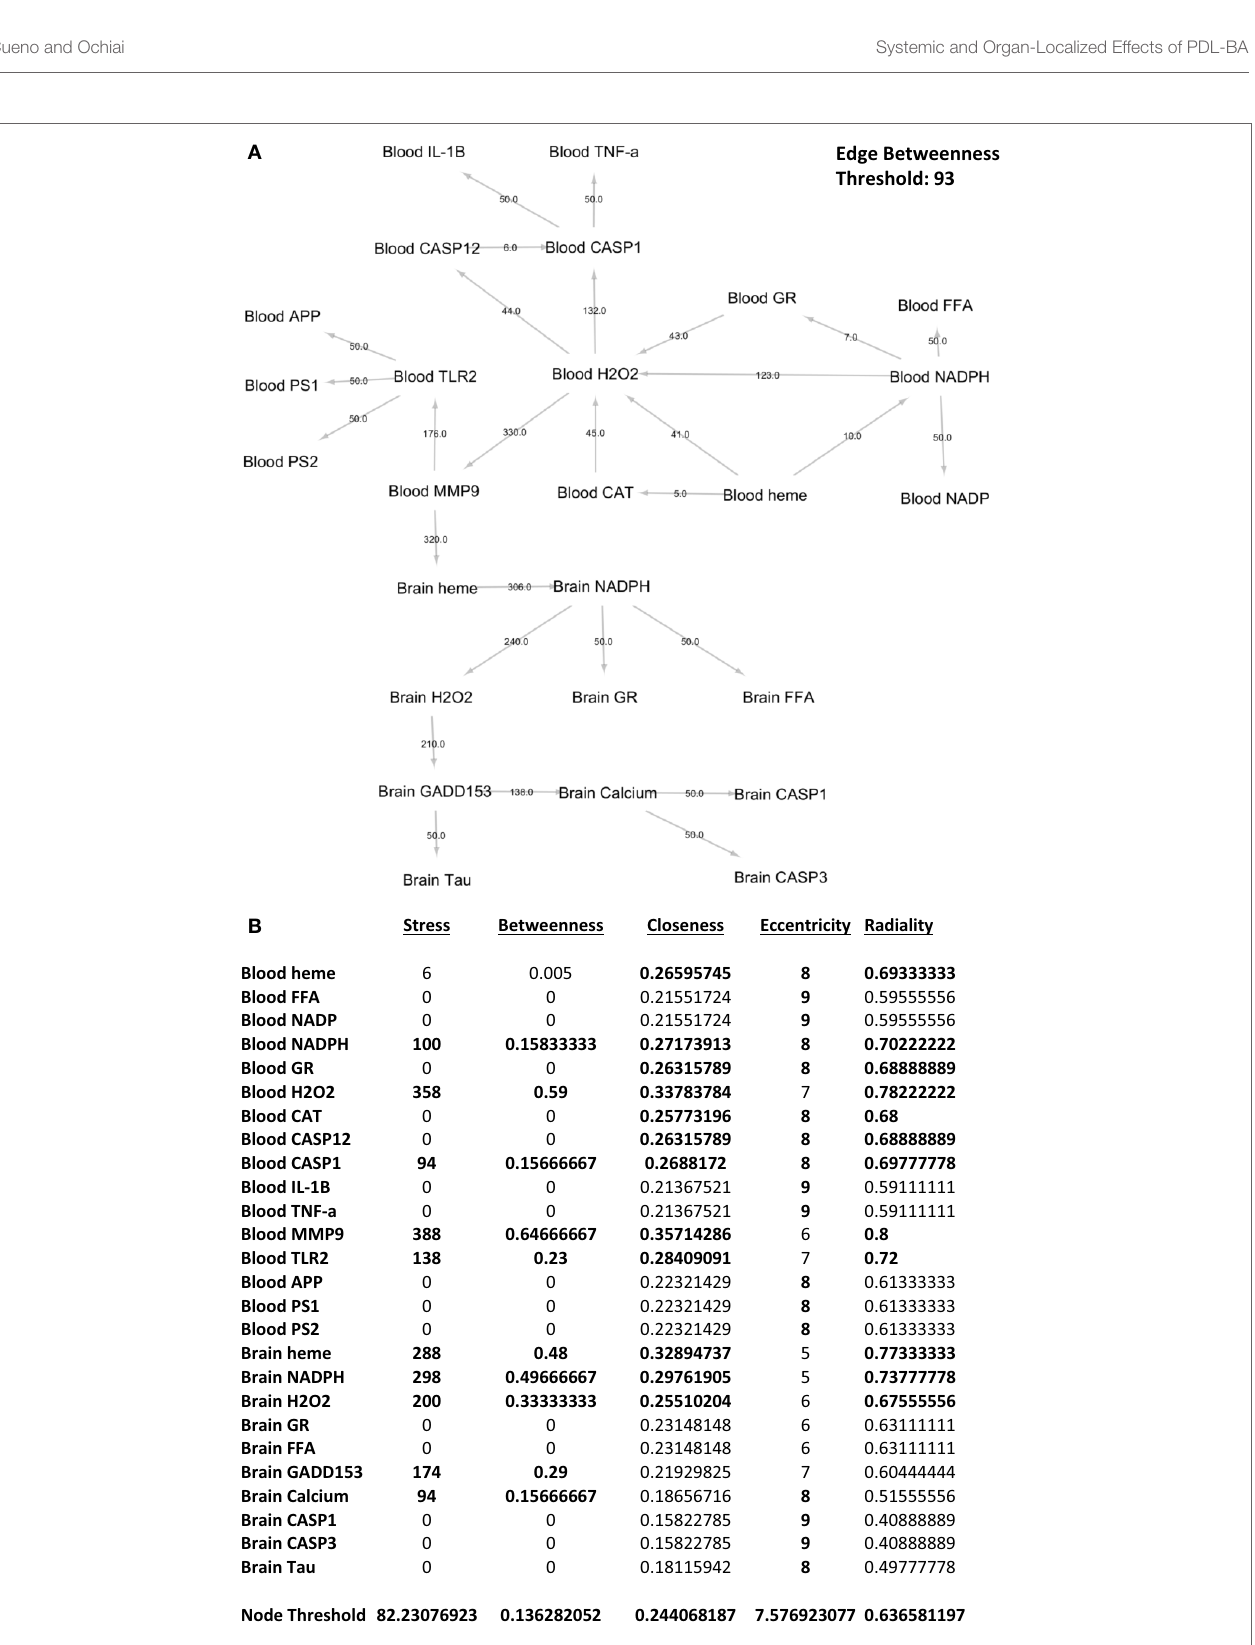
FigUre 7 | Network analyses of representative biochemical components affected by gingival periodontal disease level-butyric acid. (a) Network design of both the blood and brain biochemical components. Edge betweenness centrality data analyses are indicated over the arrows. Edge betweenness threshold is shown. (B) Centrality analyses of the blood and brain biochemical components. Values for stress, betweenness closeness, eccentricity, and radiality centralities of each component are indicated. Node threshold for each centrality measurement is